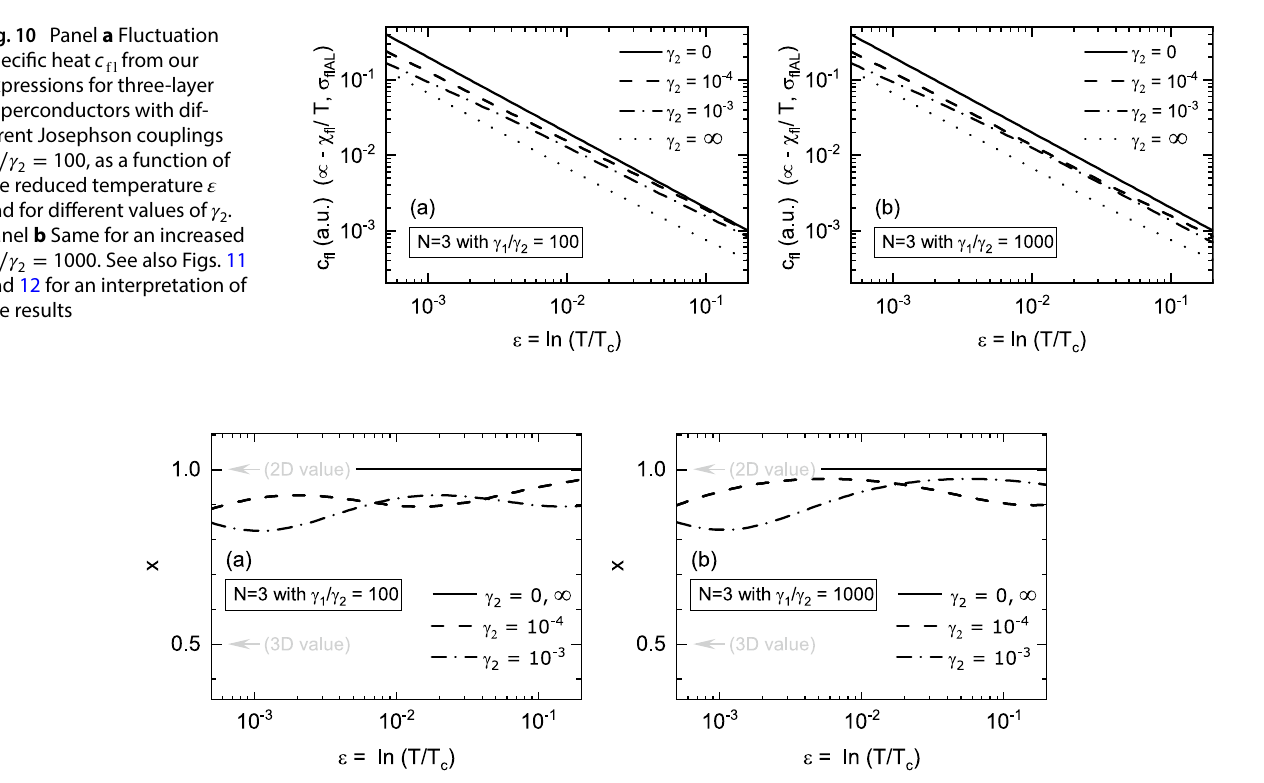
Fig. 11 Panel a Critical exponent x of c fl for three-layer supercon- ductors with 𝛾 1 ∕ 𝛾 2 = 100 , as a function of 𝜀 and for different 𝛾 2 . The figure hints at double-featured deviations from the 2D value ( x = 1 ) which may be correlated with the N e changes (and pla-